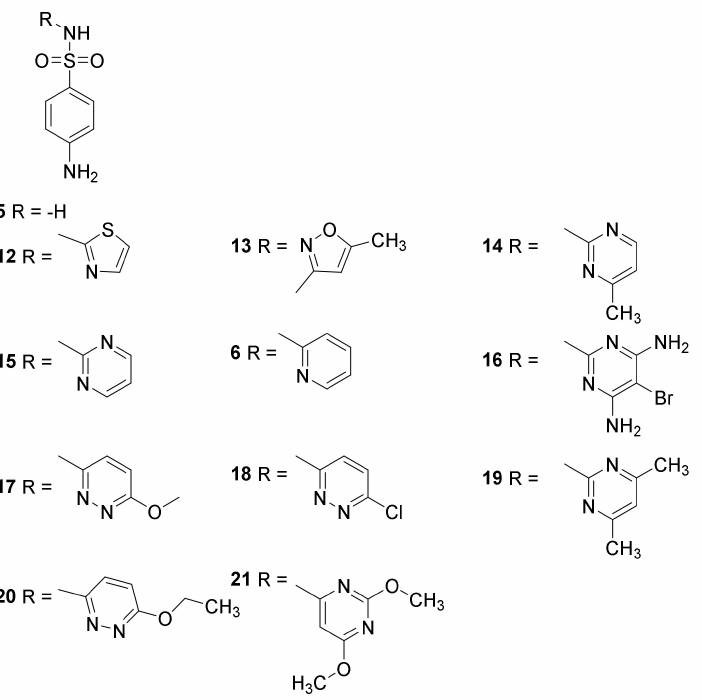
Figure 3. Clinically used sulfonamides for treatment of infectious diseases: sulfonilamide ( 5 ), sulfapyridine ( 6) , sulfathiazole ( 12) , sulfamehoxazole ( 13) , sulfamerazine ( 14) , sulfadiazine ( 15) , sulfabromomethazine ( 16) , sulfamethoxypyridazine ( 17) , sulfachloropyridazine ( 18) , sulfametazine ( 19) , sulfaethoxypyridazine ( 20) and sulfadimethoxine ( 21)